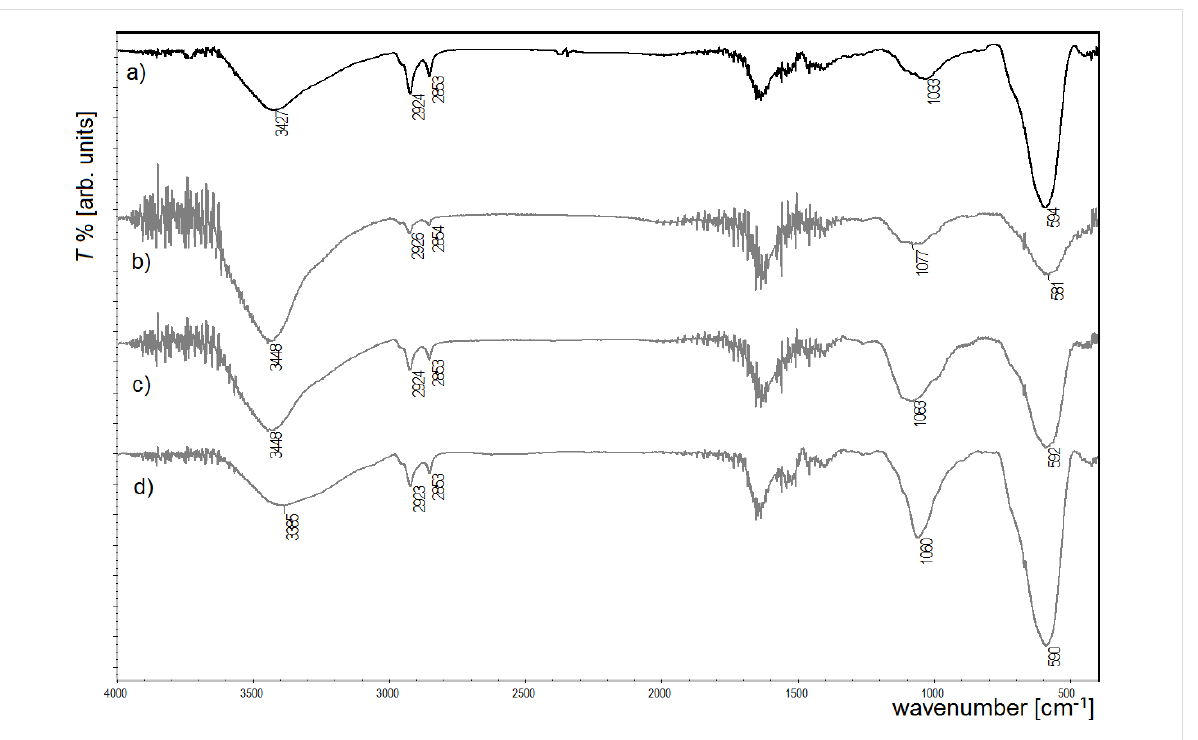
Figure 7: IR spectra of biocomposites with Mn 0.5 Fe 2.5 O 4 nanoparticles modified by glutaraldehyde and different enzymes: a) albumin, b) glucose oxidase, c) lipase, d)